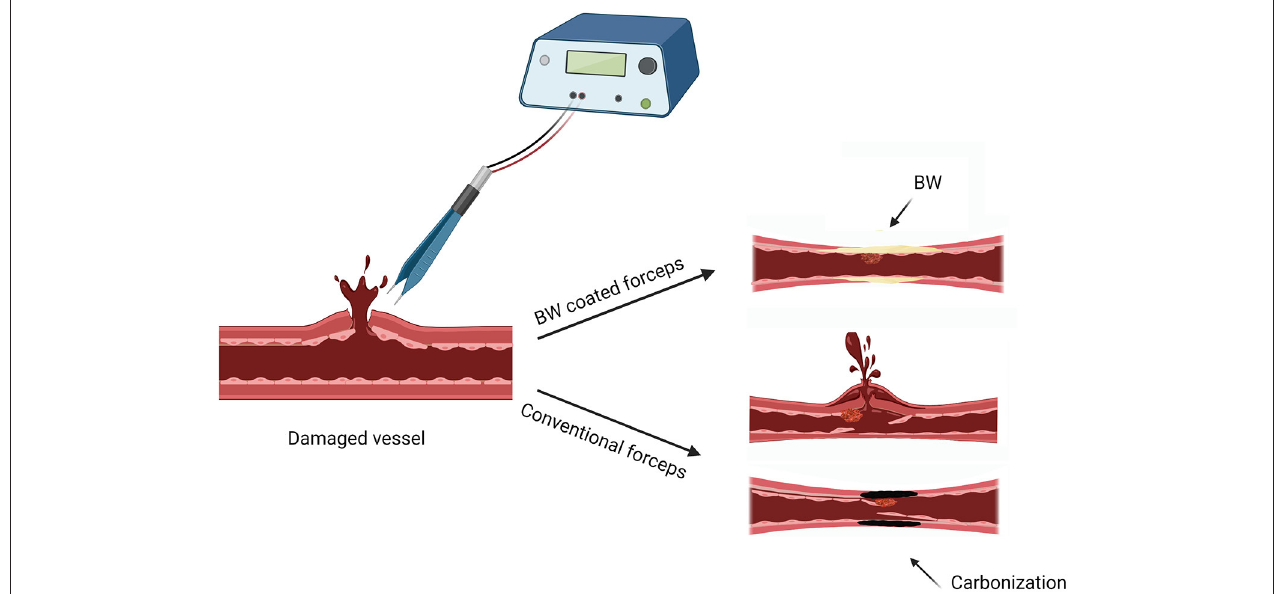
FIGURE 8 | Schematic illustrated the hemostatic mechanism (thermal and mechanical) of electrocoagulation with BW coated bipolar forceps. Created with